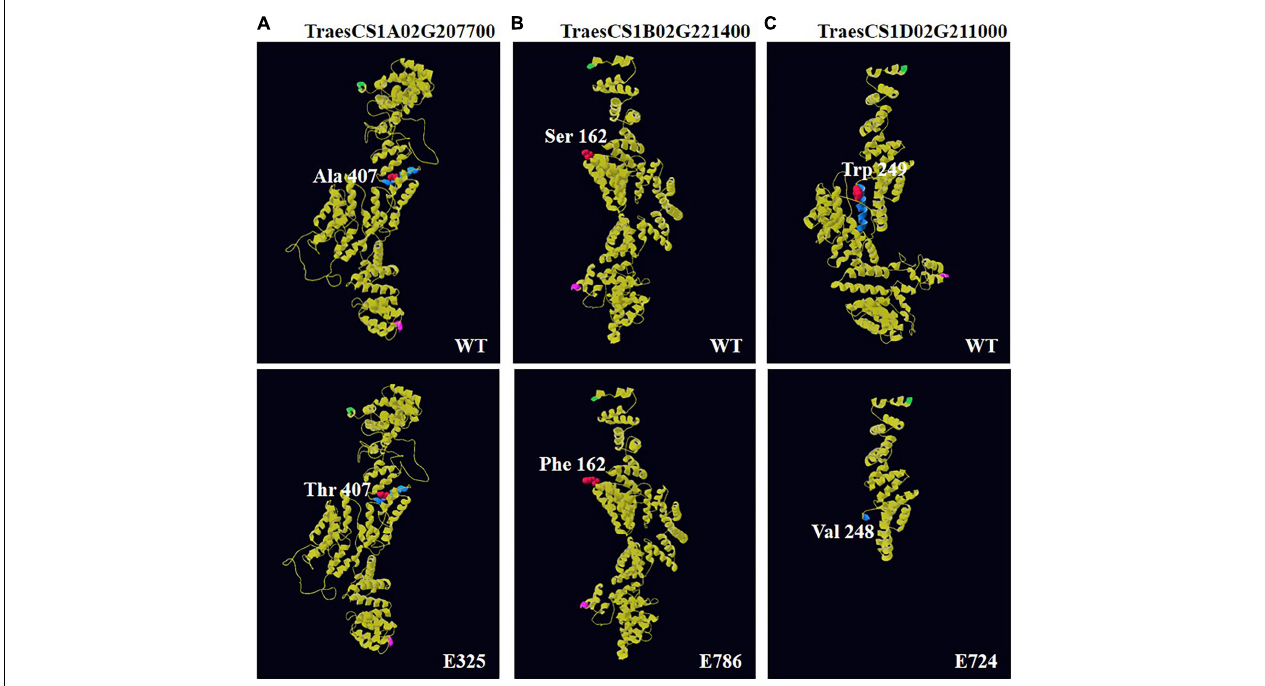
FIGURE 4 | Three-dimensional (3D) models of BSR-K1 wheat orthologs and mutants. The models were constructed using template 4buj.2.B, a S. cerevisiae Ski2-3-8 complex. (A) 3D structure of TraesCS1A02G207700 and its mutant E325; (B) 3D structure of TraesCS1B02G221400 and its mutant E786; (C) 3D structure of TraesCS1D02G211000 and its mutant E724. The N-terminal is highlighted in green, the C-terminal in pink, and the residue immediately before and after each mutation is shown in red, its secondary structure in blue.